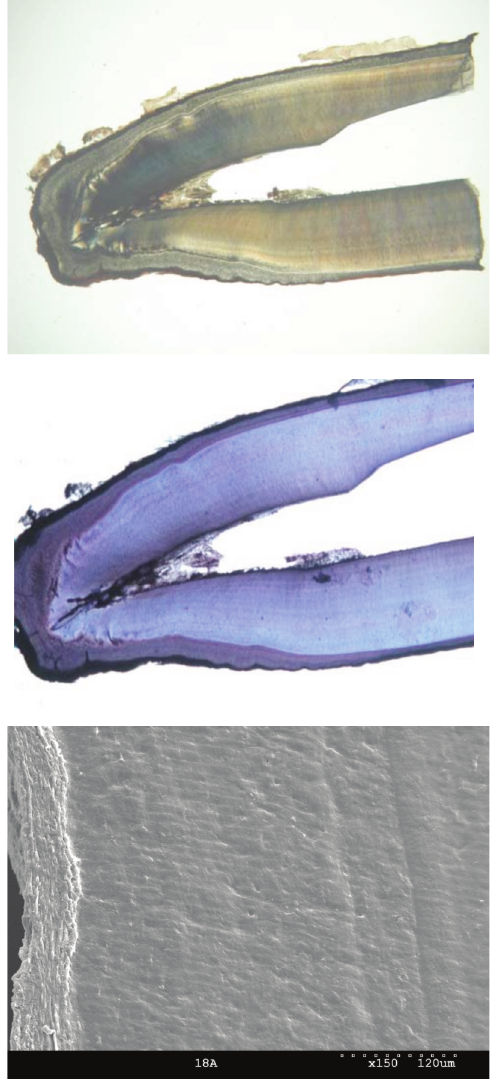
Fig. 4. Buccal-lingual sections of canine tooth from a harbour seal estimated to be 2 years old viewed a) with transmitted polar- ized light b) decalcified and stained, and c) under the SEM. The pulp cavity is visible in a) and b) which is not yet